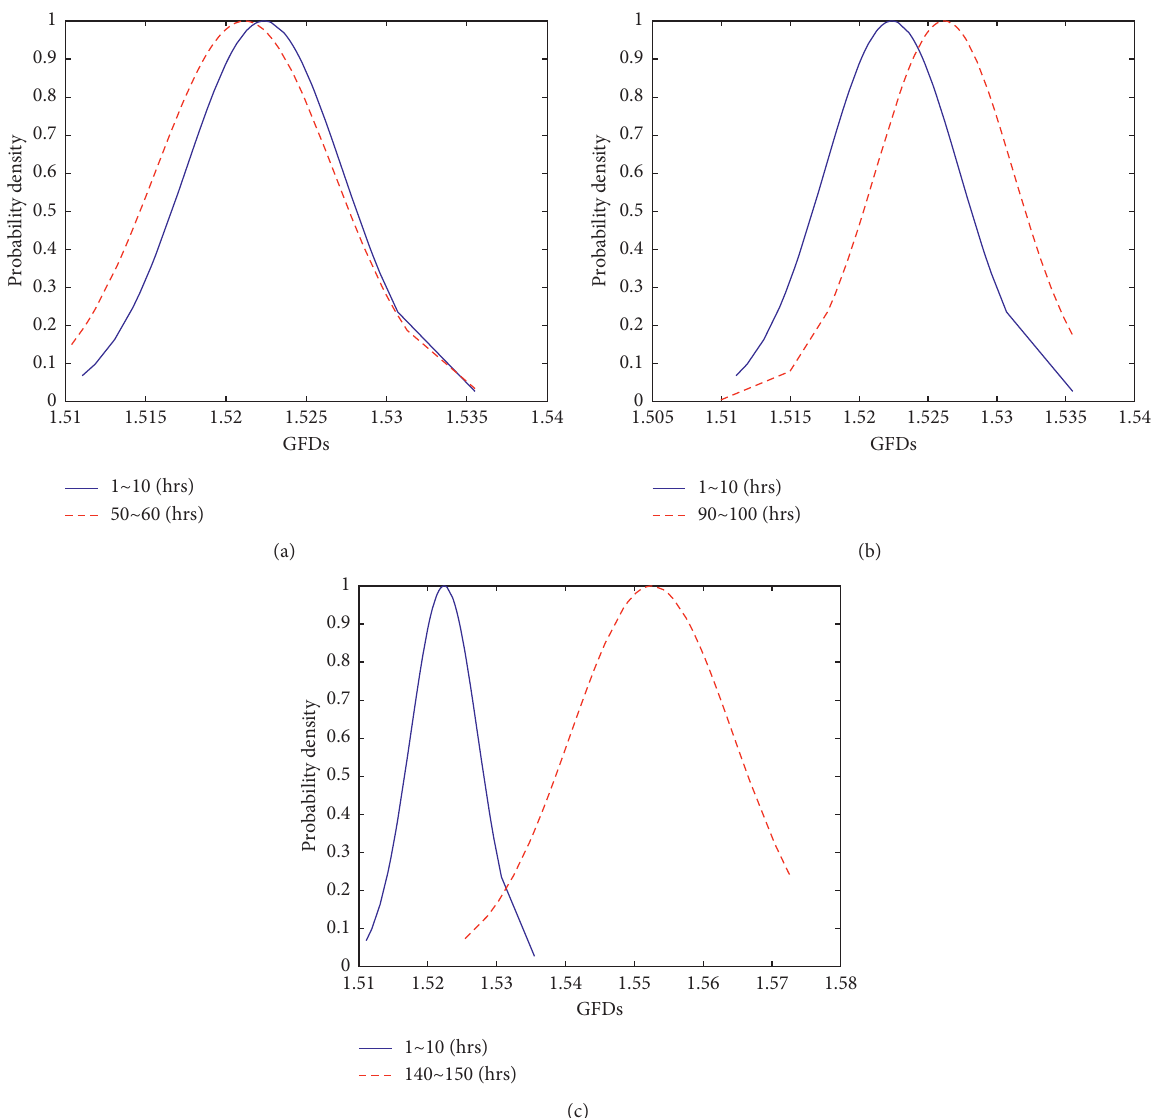
Figure 11: Gaussian distribution overlap of bearing no. 1 in the different